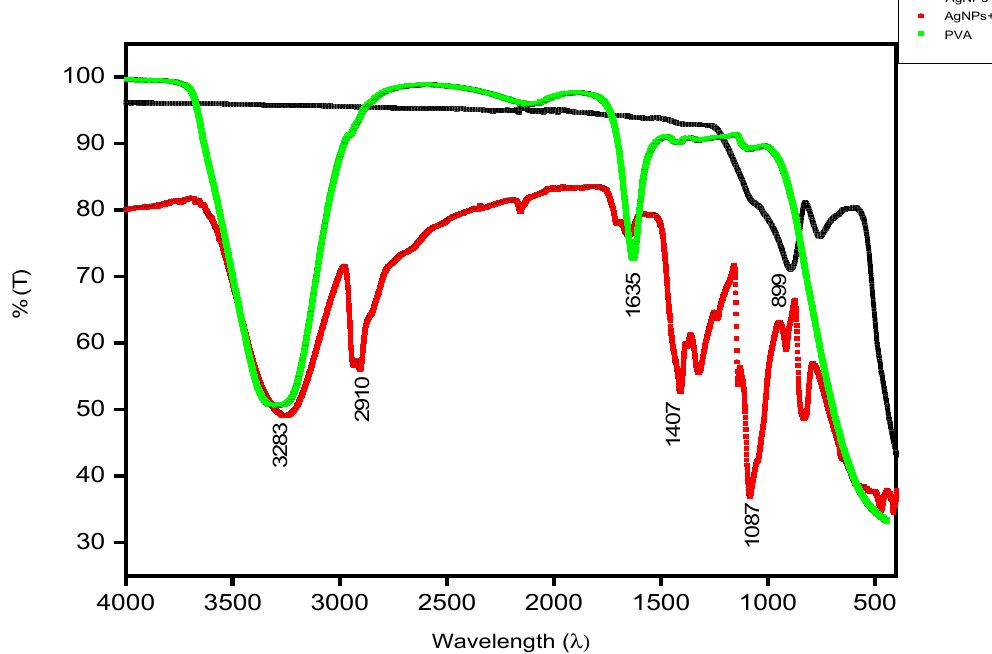
Figure 2. FTIR of AgNPs + PVA (red), PVA (green), and AgNPs (black). The FTIR of AgNPs (black curve) shows an absorption peak at 899 cm − 1 , representing O-H aromatic compounds.After adding PVA solution to the AgNPs for the fabrication of silver nanofibers, the final FTIR was conducted (red curve). The peaks show the bond formation at 3283 cm − 1 corresponding to O-H vibration, 2910 cm − 1 shows C-H stretching, 1407 cm − 1 shows C-H 2 methylene groups, 1087 cm − 1 shows C=O stretching, which shows a strong bond between 80%T to 40%T. Moreover, FTIR of PVA (green) in pure form was done and the peaks reported at wavelengths 3283 cm − 1 and 1635 cm − 1